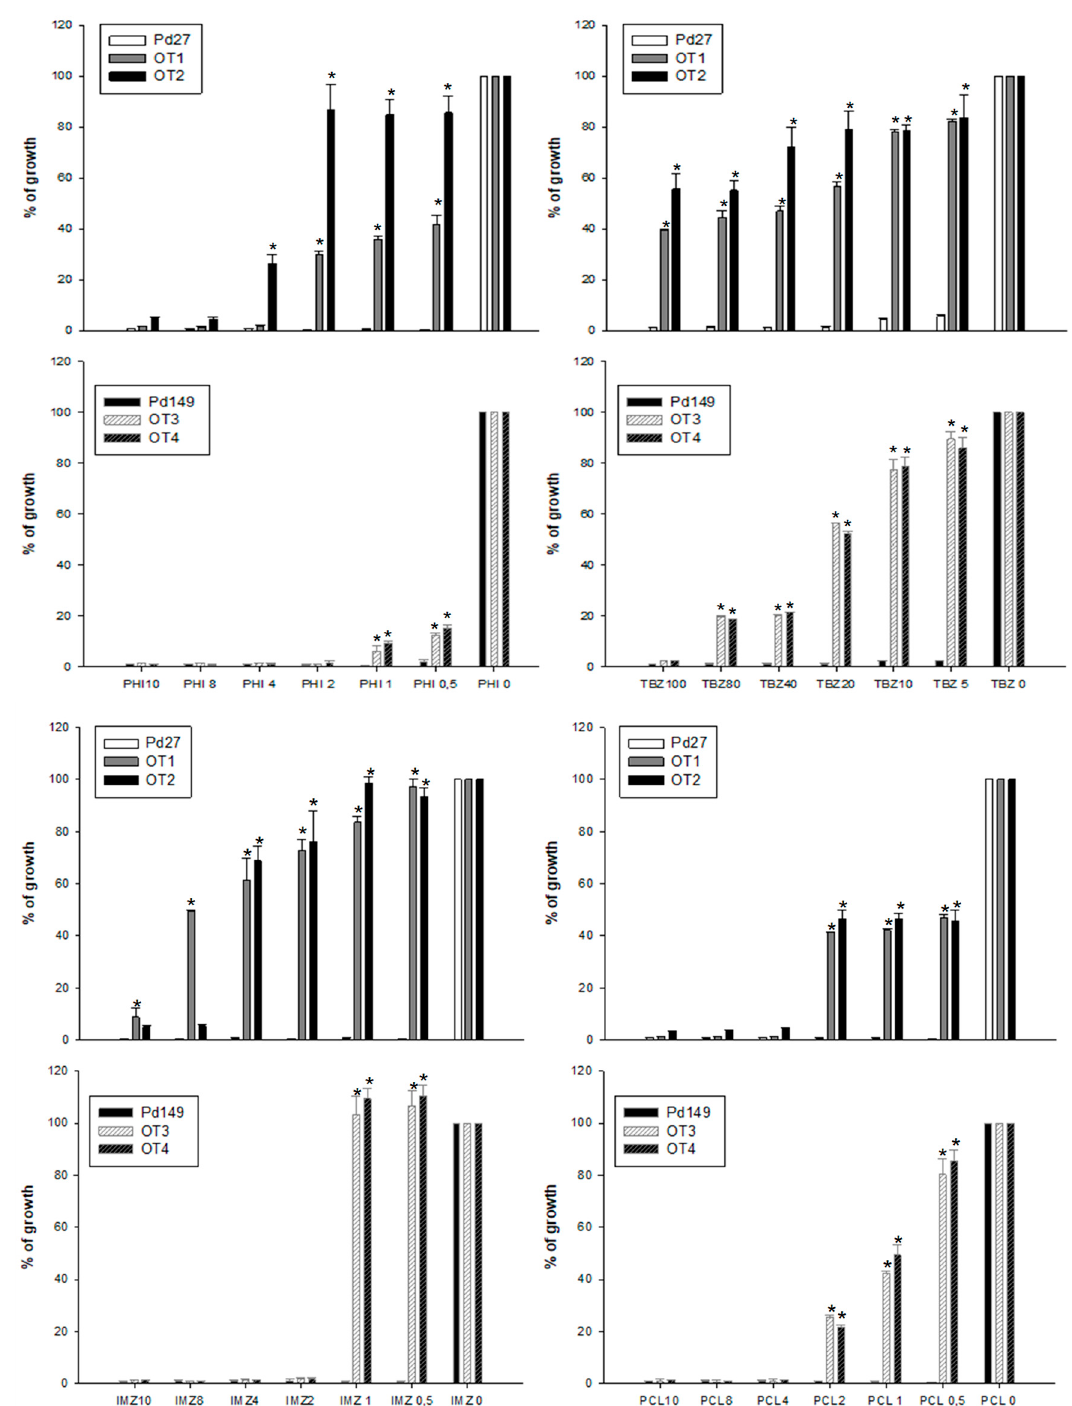
Figure 5. Evaluation of fungicide sensitivity in Pd27-(OT1, OT2) and Pd149-overexpression mutants (OT3, OT4) compared to both wild-type Pd27 and Pd149, respectively. PHI = Philabuster, TBZ = Thiabendazol, IMZ = imazalil, PCL = Prochloraz. The fungicides concentration is expressed in μ g/mL. Percentage of relative growth was calculated respect to the each strain grown without fungicide. Error bars represent standard deviation among three replicas. * Significant differences between treatments using Tukey’s test ( p < 0.05).